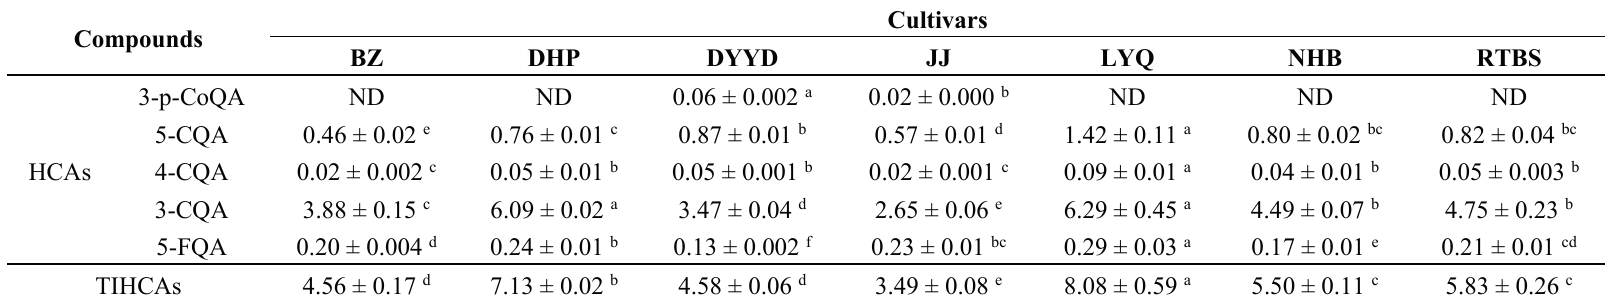
Table 4. Contends of individual phenolic compounds in the pulp of seven loquat cultivars (mg/g DW).